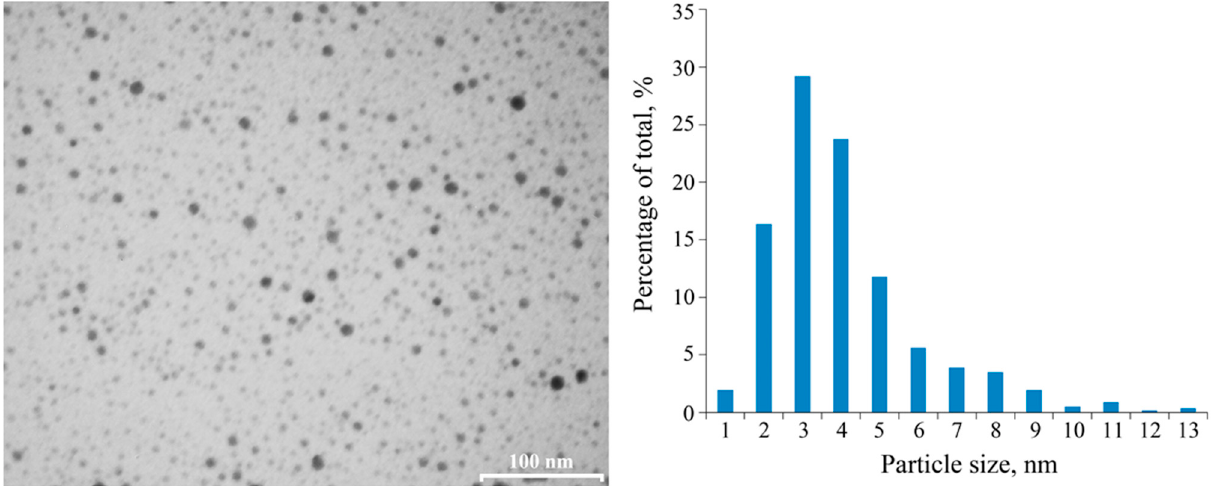
Figure 3. TEM image of the freshly synthesized PAAg film and size distributions of nanoparticles.